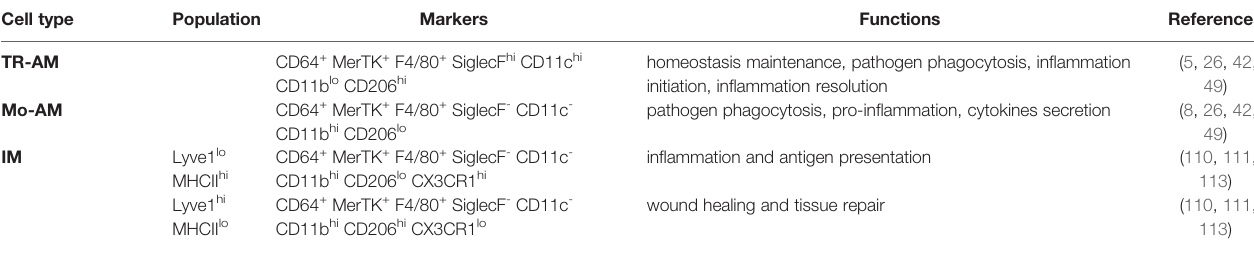
TABLE 1 | Markers and functions of lung